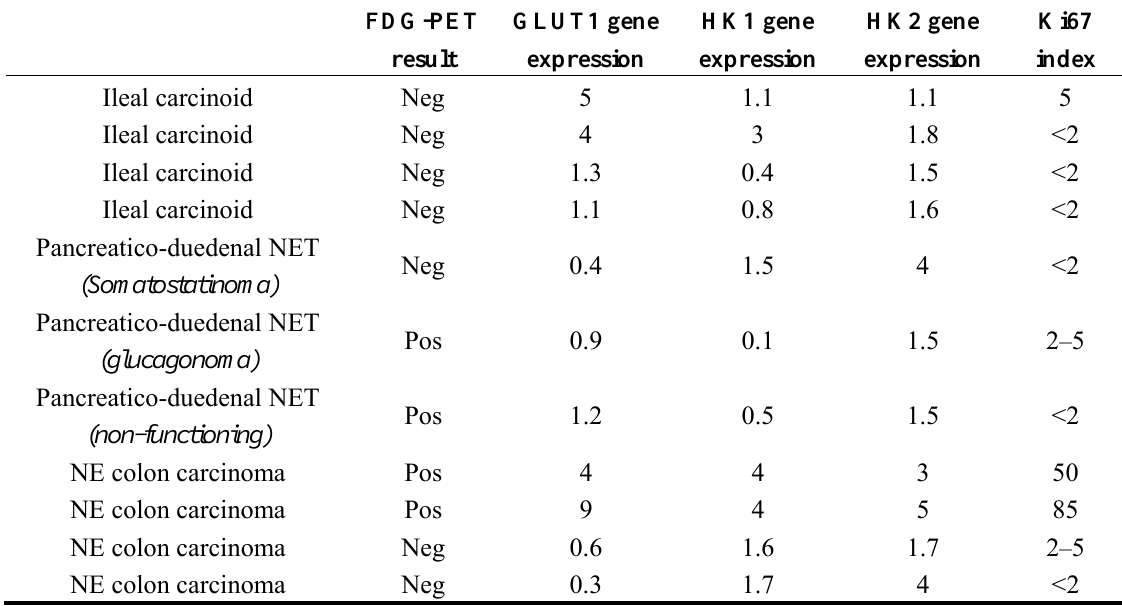
Table 2. 18F-Fluorodeoxyglucose-positron emission tomography (FDG-PET) results, gene expression and proliferation index in the NET group. The gene expression level is expressed as the level in the tumor relative to the level in the non-cancerous